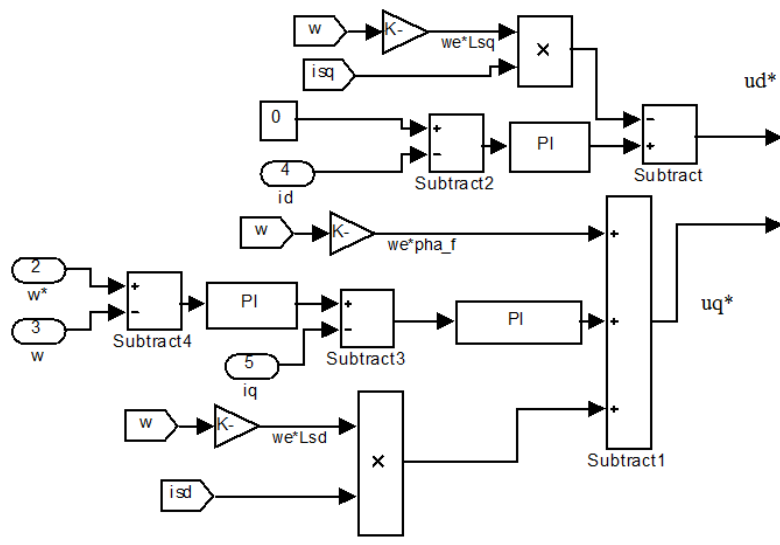
Figure 2. Simulink model of the generator side converter.